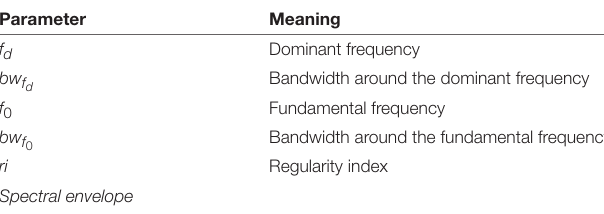
TABLE 1 | Parameter